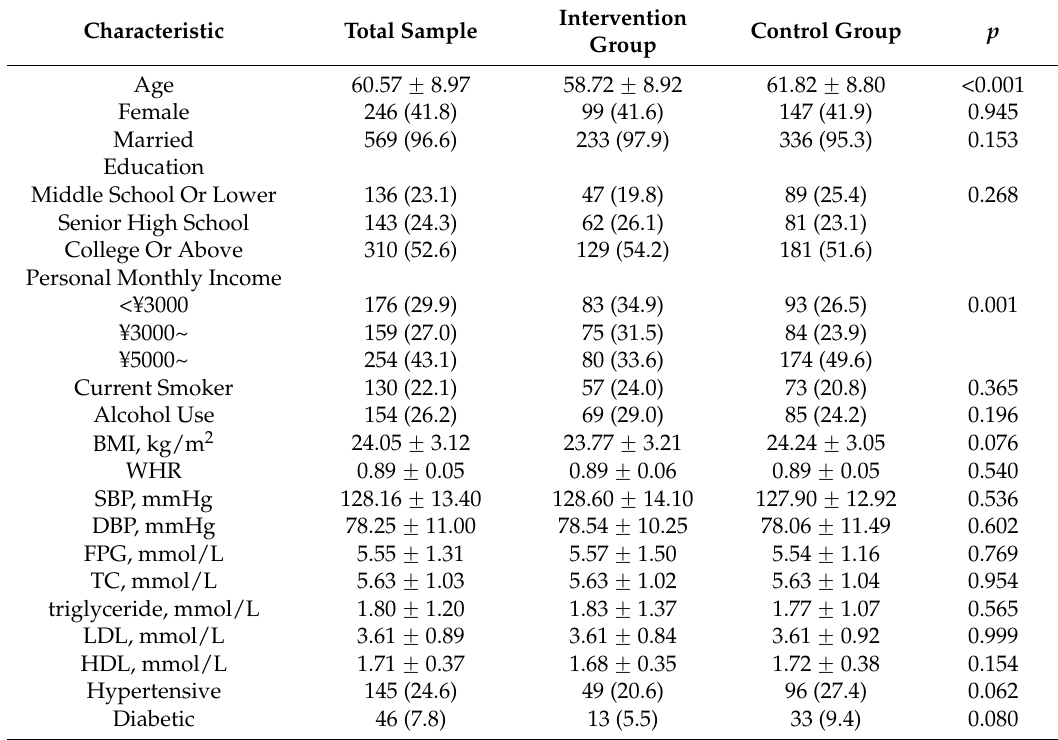
Table 2. Baseline participant characteristics ( n (%)/Mean ˘